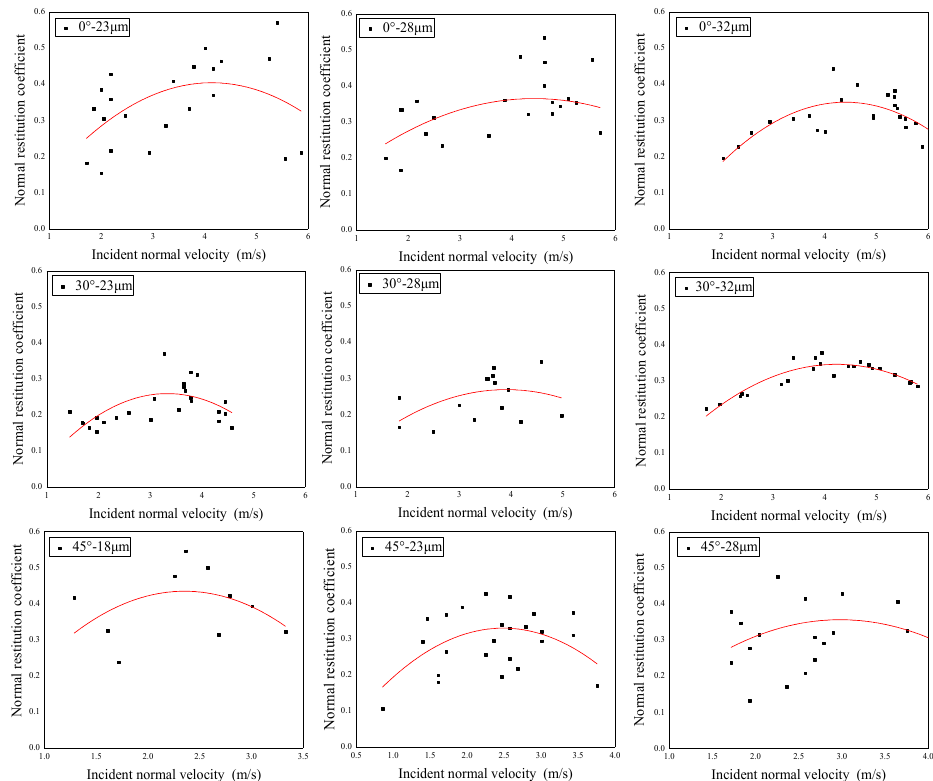
Figure 7. The ash particles with different particle sizes impact on the e n − V in curve of the stainless steel surface at different incident angles.